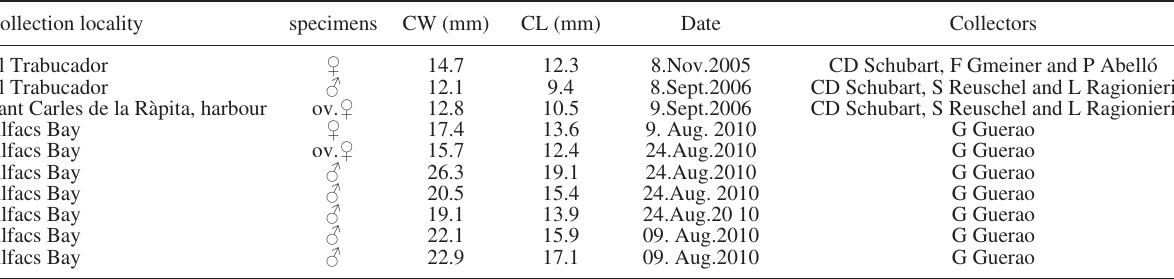
Table 1. – Specimens of Dyspanopeus sayi (Smith, 1869) collected from the Ebro Delta. Collection locality